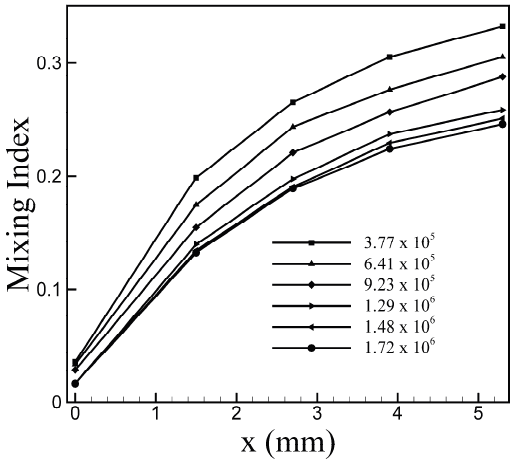
Figure 2. Grid dependency test for reference three-split micromixer ( w 1 = 0.2 mm, w 21 = 0.05 mm, and w 22 = 0.05